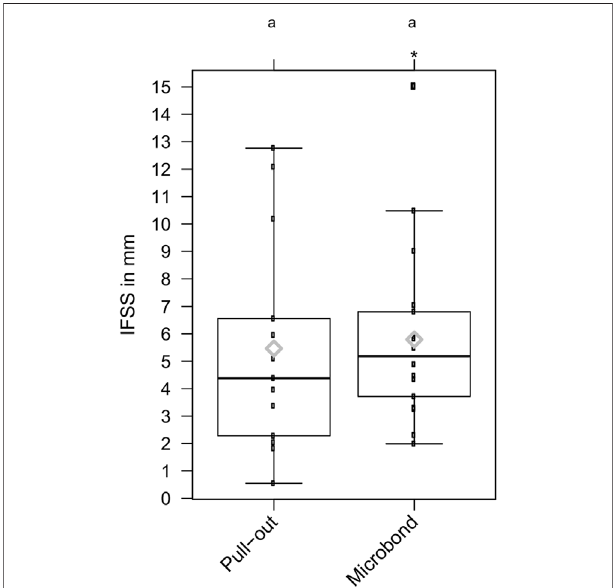
FIGURE 8 | Interfacial shear strength (IFSS) of Danu fi l 28 dtex fi bres embedded in an epoxy matrix determined by pull-out and microbond tests. ResultsareshownasBox-Whisker-Plotswiththemeanvaluesasrhombuses. No signi fi cant differences were found. A * marks results which do not follow a normal distribution.